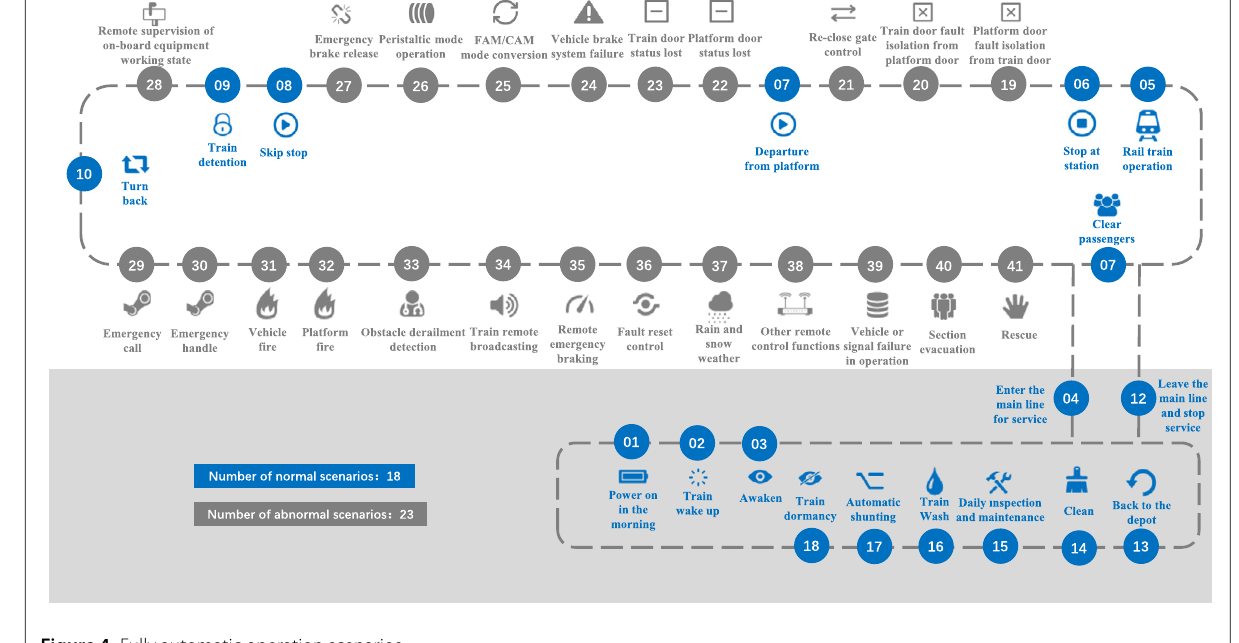
Figure 4 Fully automatic operation scenarios